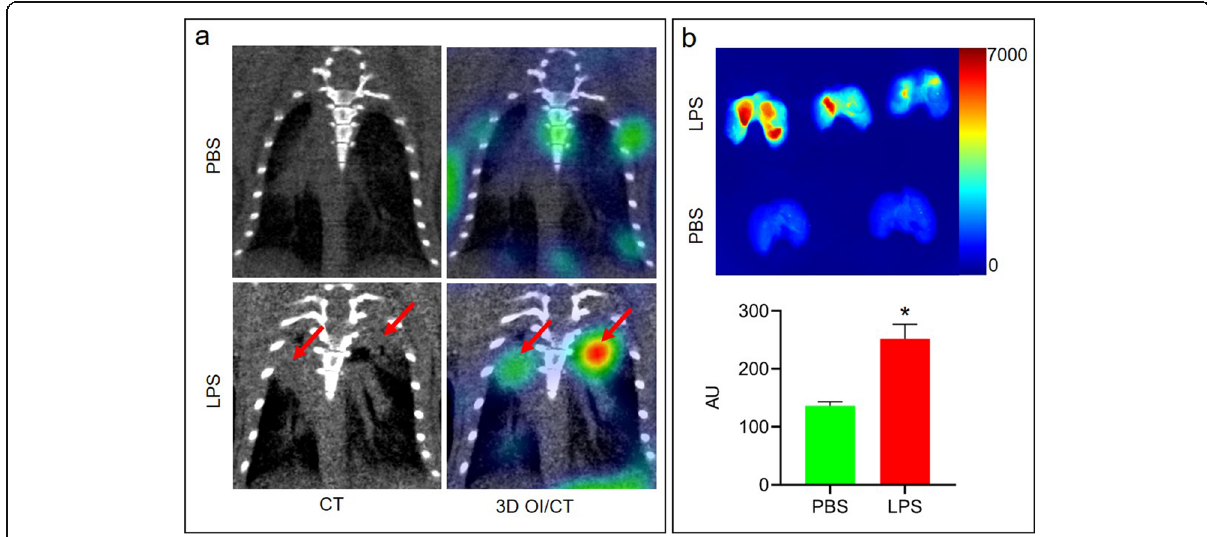
Fig. 1 3D OI/CT detection of LPS-induced lung inflammation using Cy7-albumin. a representative coronal images of Cy7-albumin uptake in the lungs of the PBS (top, n = 4) and LPS (bottom, n = 5) treated mice 24 h post injection. CT (left panels) and fusion 3D OI/CT (right panels) are shown. Note that infiltrates visible on CT (red arrows) are co-localized with Cy7-albumin accumulation detected by the 3D optical scan. b Cy7- albumin is detected in dissected lungs of mice treated with LPS ( n = 5) or PBS ( n = 4, control). *, p < 0.01